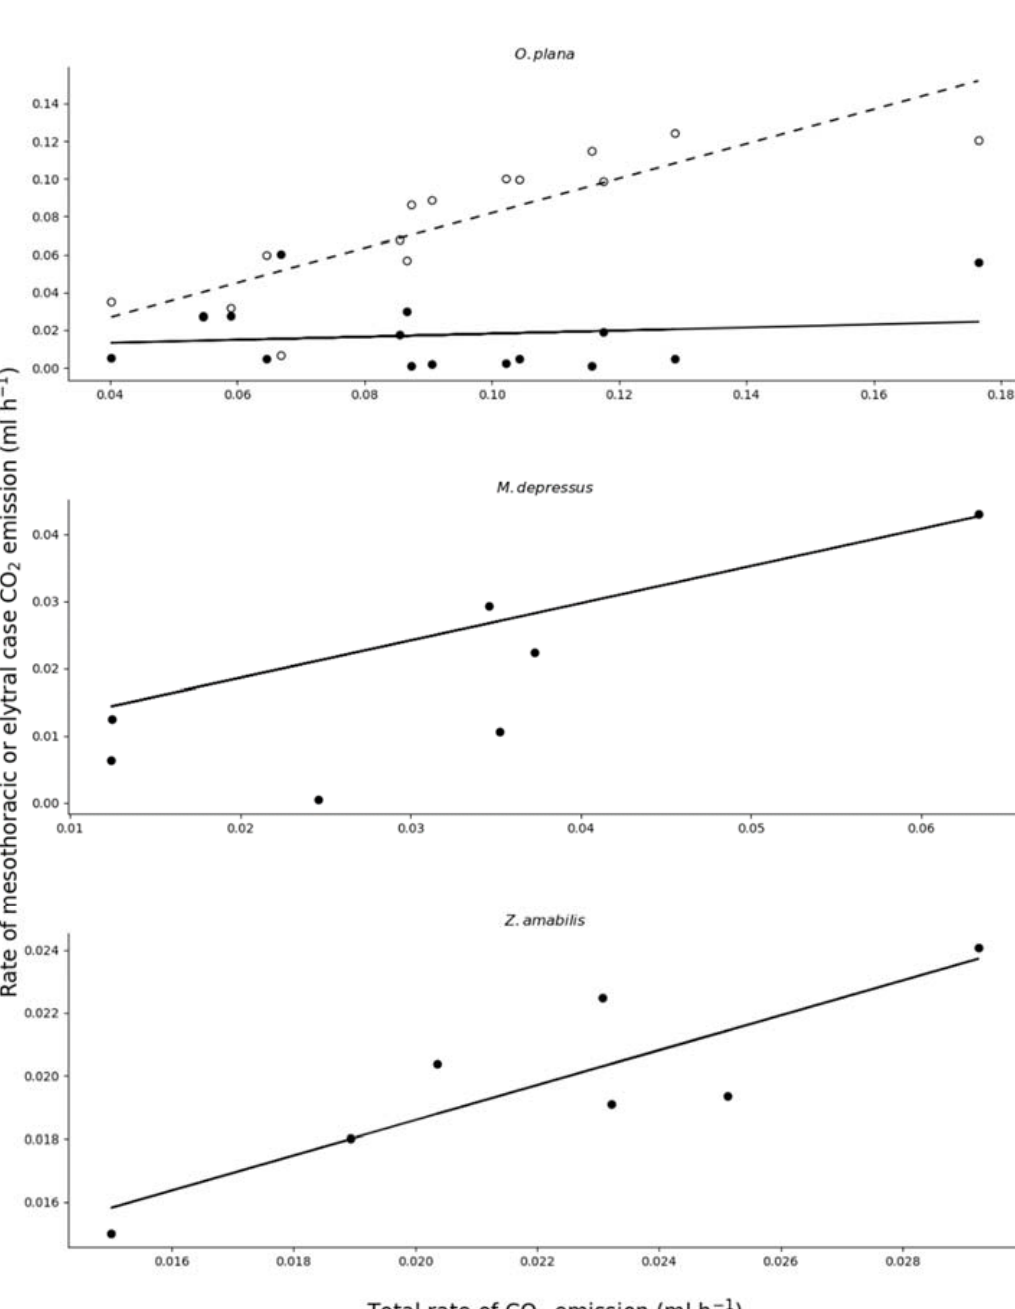
) as a function (cid:35) . V CO2 , el = elytral case   V V CO2 , el = elytral case CO2 , t =